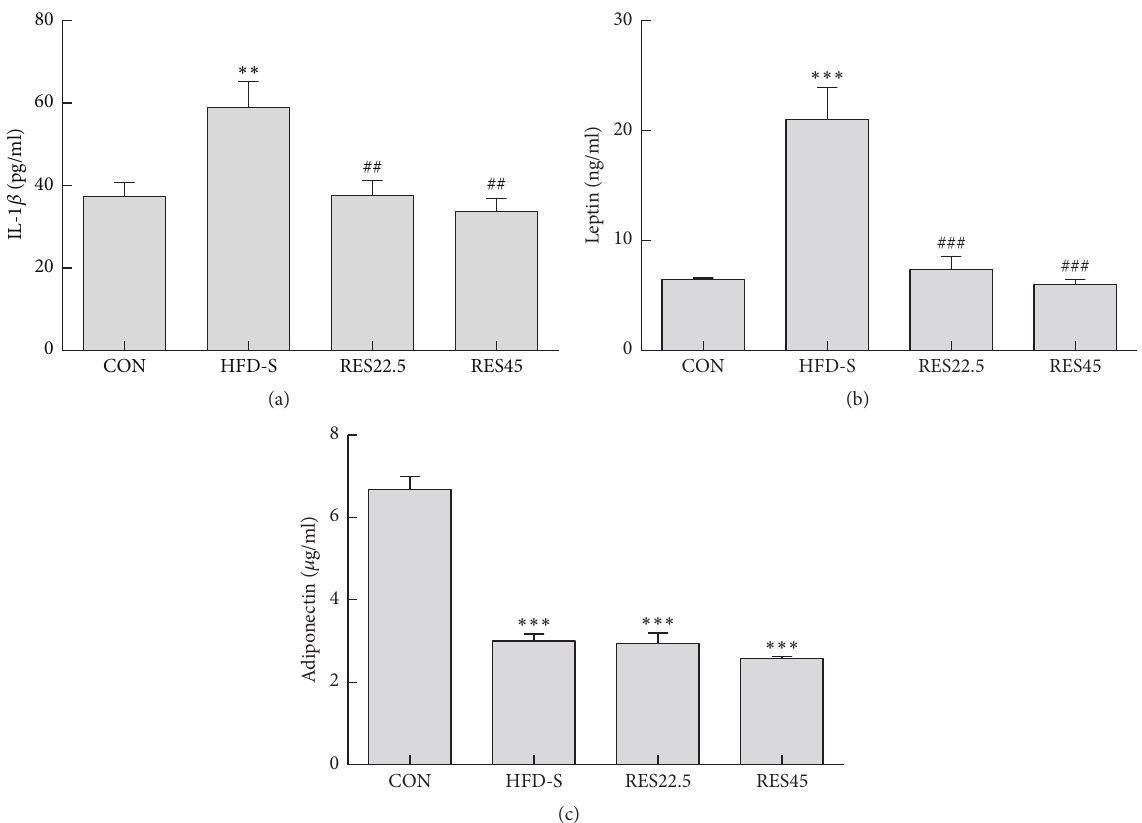
Figure 3: Serum cytokine concentrations of IL-1 𝛽 (a), leptin (b), and adiponectin (c). 𝑛 = 5 mice per group. One-way ANOVA was used to test for statistical significance. Data were expressed as the mean ± SEM. ∗∗ 𝑃 < 0.01 and ∗∗∗ 𝑃 < 0.001 versus the CON group; ## 𝑃 < 0.01 and ### 𝑃 < 0.001 versus the HFD-S